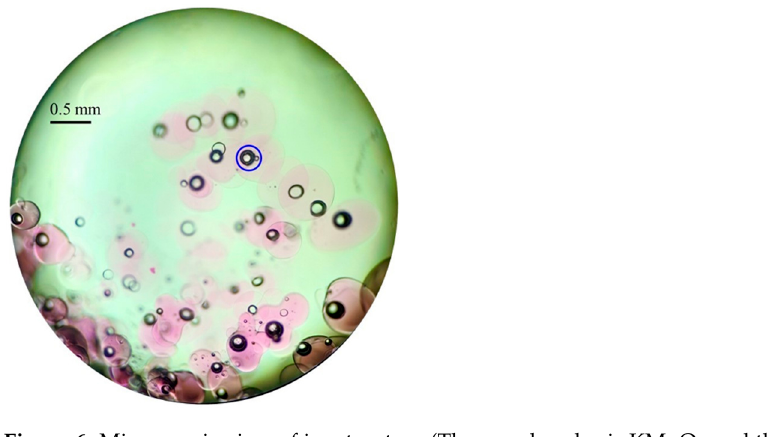
Figure 6. Microscopic view of ice structure (The purple color is KMnO 4 and the blue circles indicate the formation of a trapped bubble during the freezing process).